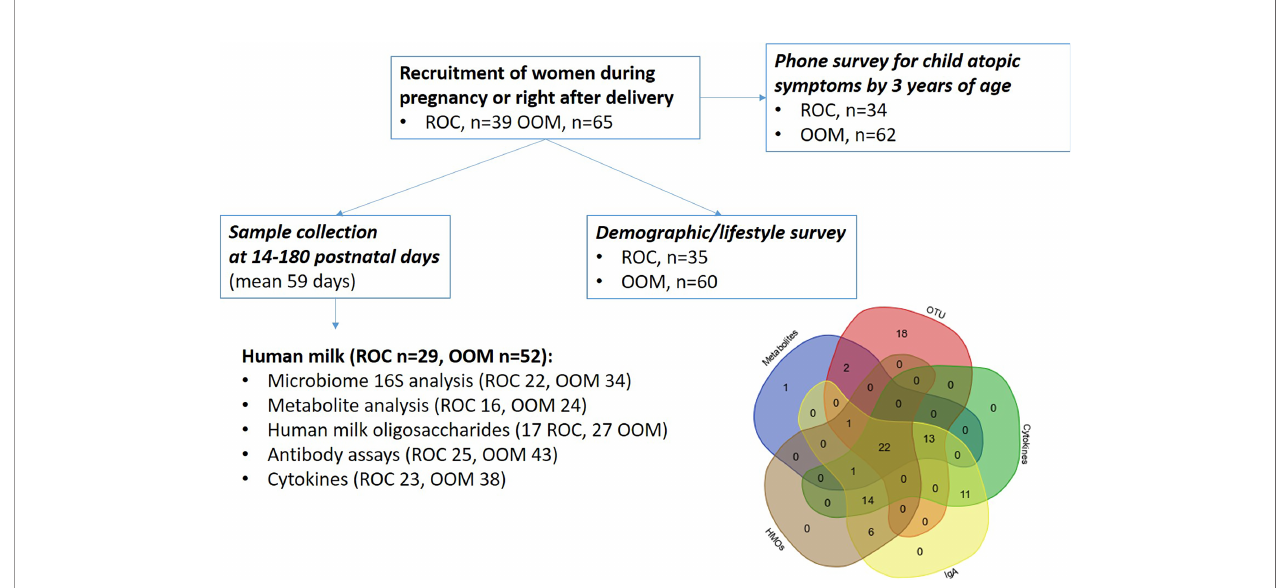
FIGURE 1 | Schematic describing the cohort, samples, and assays of mother-infant pairs. OOM, Old Order Mennonite; ROC,